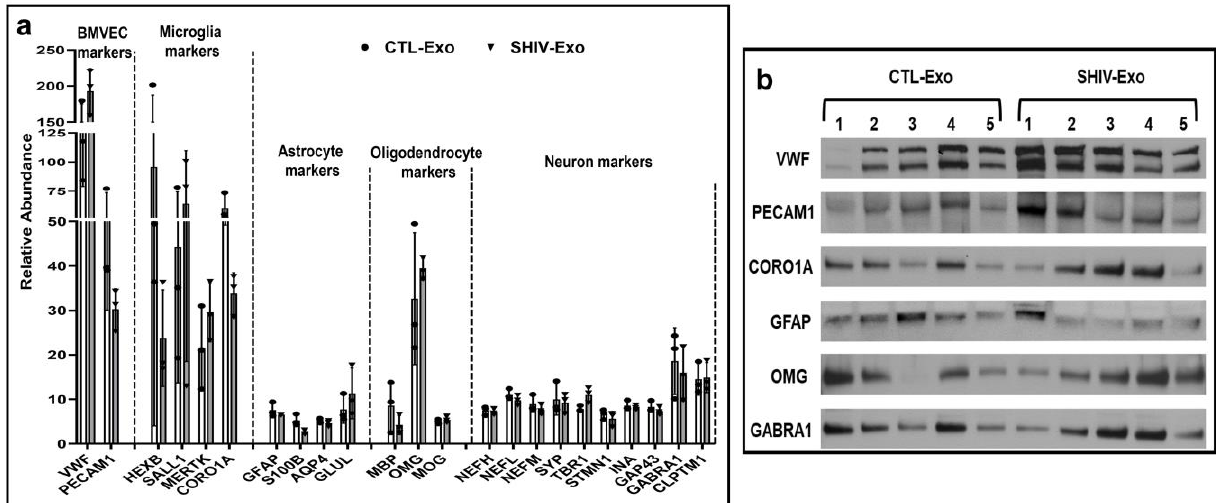
Figure 4. Relative abundance of CNS cell markers in circulating plasma exosomes. ( a ) Central nervous system (CNS) cells-specific exosomal proteins in CTL-/SHIV-Exo were quantified by proteomic analysis. Proteins that exhibited group differences shown as bar graphs with white and gray for CTL-Exo and SHIV-Exo, respectively. Plasma exosomes were isolated from three SHIV-infected and three uninfected RM (N = 3/group). Graphs show mean ± SD of relative abundance calculated from four experimental replicates per sample. For a protein group not passing the normality test, a non-parametric Mann–Whitney test was performed. There were no significant differences ( p < 0.05) between groups. ( b ) The indicated proteins were further validated by Western blotting. For this assay, plasma exosomes were isolated from five SHIV-infected and five uninfected RM (N = 5/group). Protein coding gene names are presented here and were described in the text. CTL-Exo: Plasma exosomes isolated from uninfected RM; SHIV-Exo: Plasma exosomes isolated from SHIV-infected RM. BMVEC: Brain microvascular endothelial